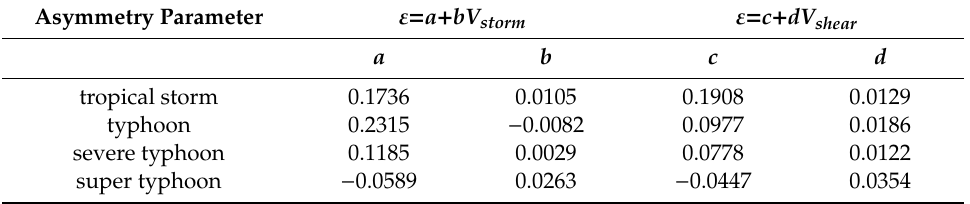
Table 3. Linear regression coe ffi cients for the asymmetry parameter ( ε ) versus the typhoon